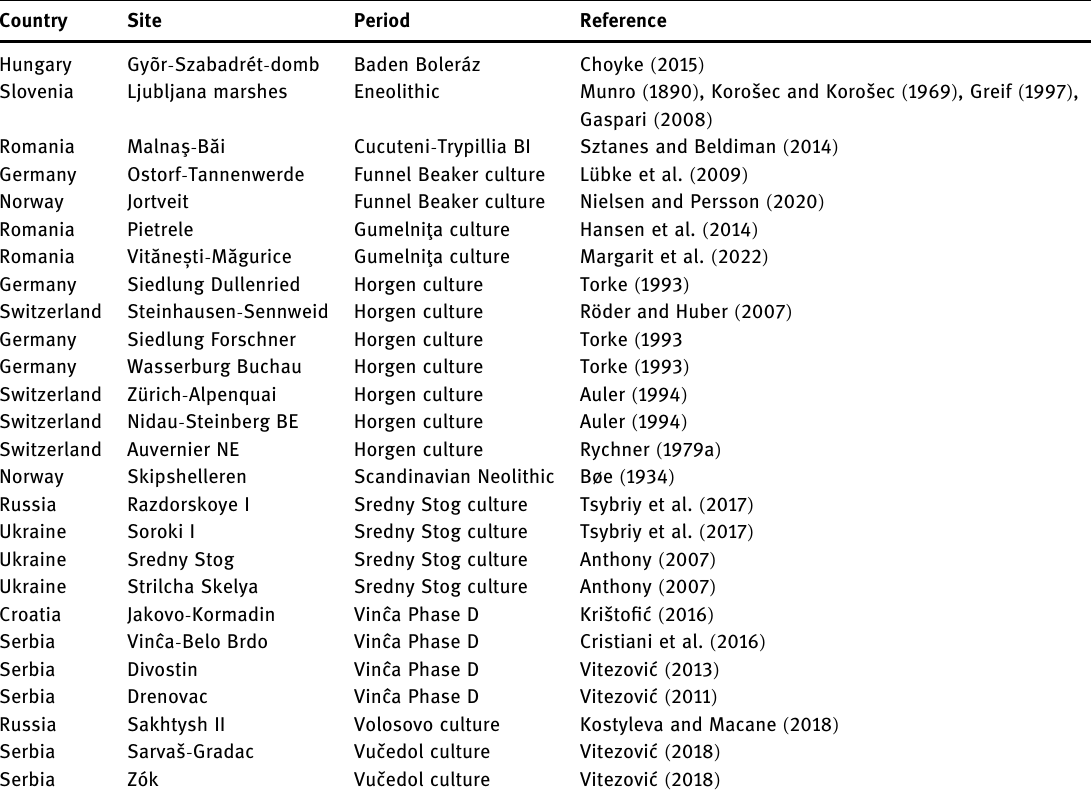
Table 2: List of sites with toggling harpoons mentioned in the text Country Site Period